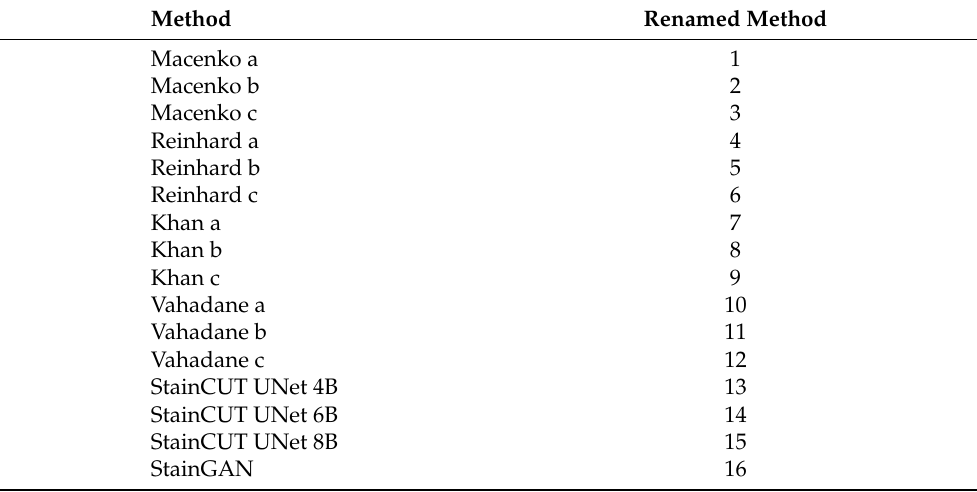
Table A2. Rows/Columns corresponding to methods in the stain transfer experiment.